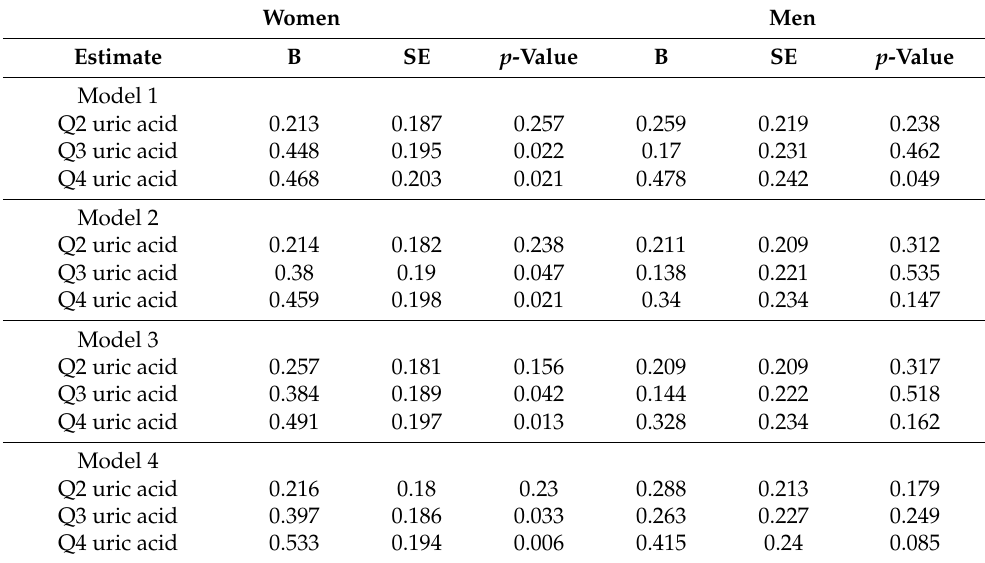
Table 6. Multiple linear regression analysis with cfPWV as dependent